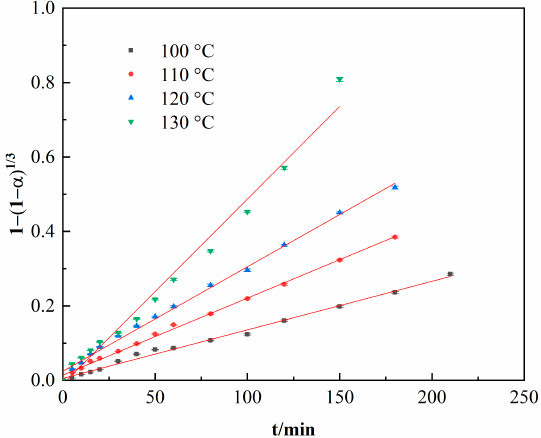
Figure 3. Relationship between 1 − (1 − α ) 1/3 and time at different temperatures.